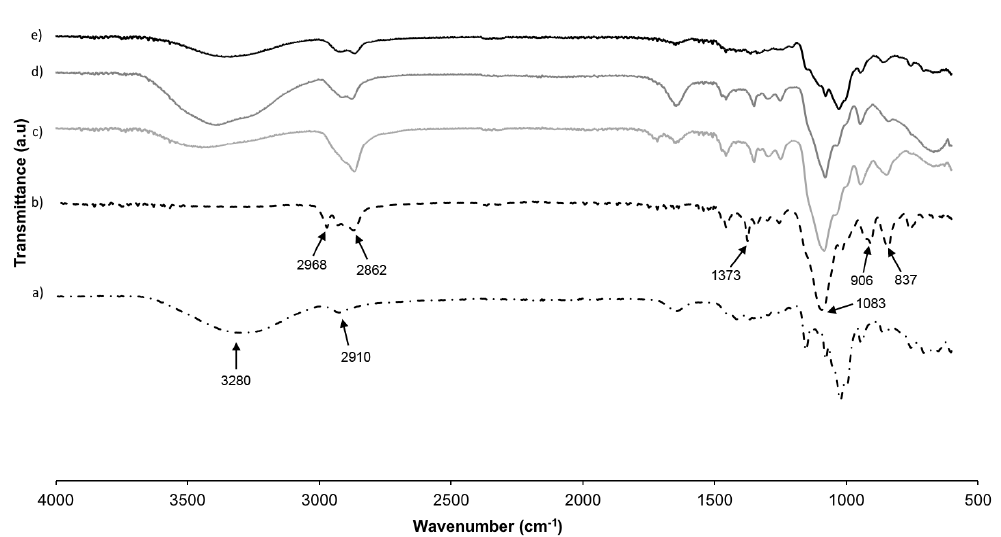
Figure 1. FTIR spectra of ( a ) β -CD, ( b ) EDGE or PEDGE, ( c ) PEGCD1, ( d ) EGCD and ( e ) PEGCD2.